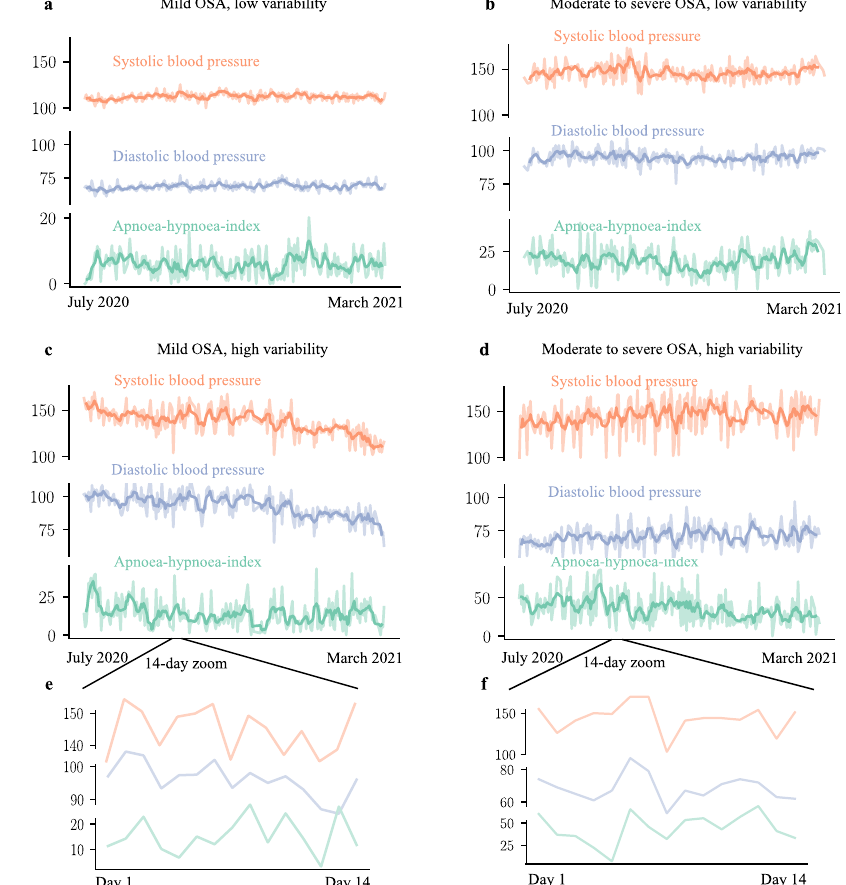
Fig. 1 Nightly variation in systolic and diastolic blood pressure and estimated apnea – hypopnea index. Night-to-night variation in systolic (orange) and diastolic (blue) blood pressure and estimated apnea – hypopnea index (AHI; green) for participants with mild OSA (mean AHI > 5 but <15 events/h sleep) and either low ( a ) or high night-to-night variability ( c ) in AHI. Participants with moderate-to-severe OSA (mean AHI > 15 events) and either low ( b ) or high ( d ) night-to-night variability in AHI. e and f tracings represent a zoomed-in 14-day period of examples c and d (high night-to-night AHI variability) to show the temporal relationship between AHI and blood pressure variability. Darker lines are smoothed averaged over 7 days and light lines are raw data. Note: the temporal association between low night-to-night variability in AHI and blood pressure in panels a and c — and between high night-to-night variability in AHI and blood pressure in panels ( b ) and ( d